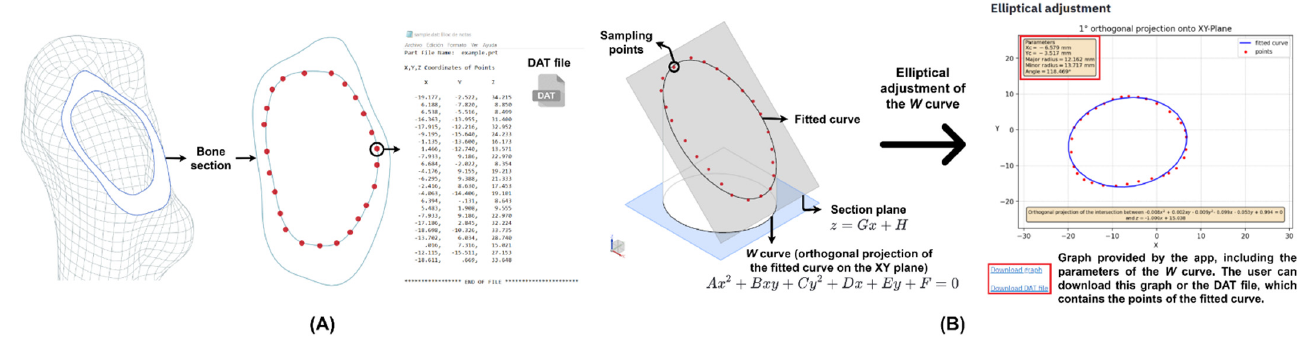
Figure 2. ( A ) Bone section sampling and DAT file. ( B ) Representation of the fitted curve and the elliptical adjustment of its orthogonal projection.